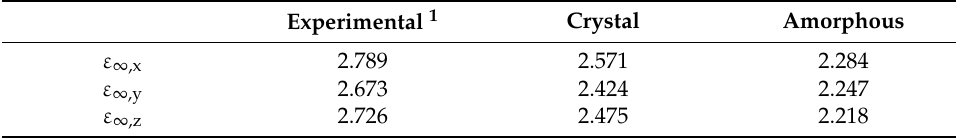
Table 4. High-frequency dielectric constants ( ε ∞ ) for the Mg 2 SiO 4 bulk structures along the x, y, and z directions: experimental values of the crystal system and B3LYP-optimized values of the crystal and amorphous